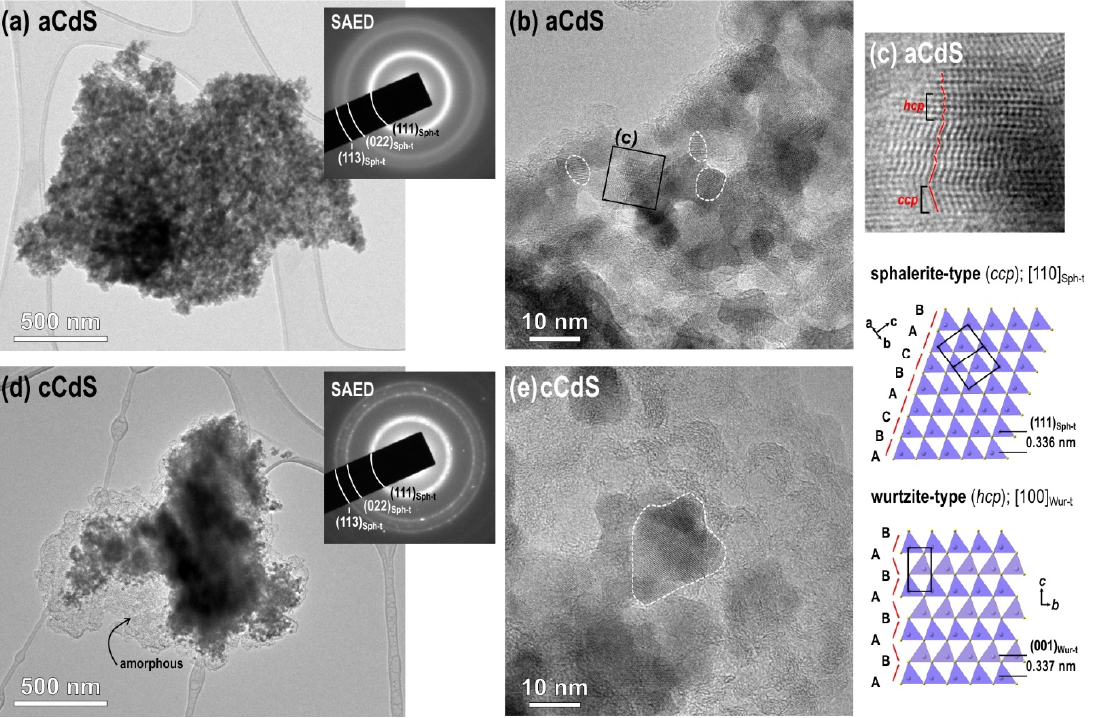
Figure 8. TEM analysis of the mechanochemically synthesized CdS samples: low-magnification images of the ( a ) aCdS and ( d ) cCdS samples with SAED; high-resolution TEM analysis of the ( b ) aCdS and ( e ) cCdS samples; ( c ) detailed analysis of aCdS sample.